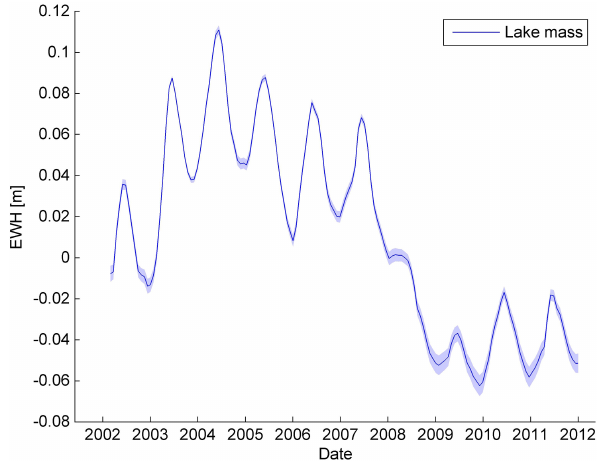
Figure 8. Lake mass